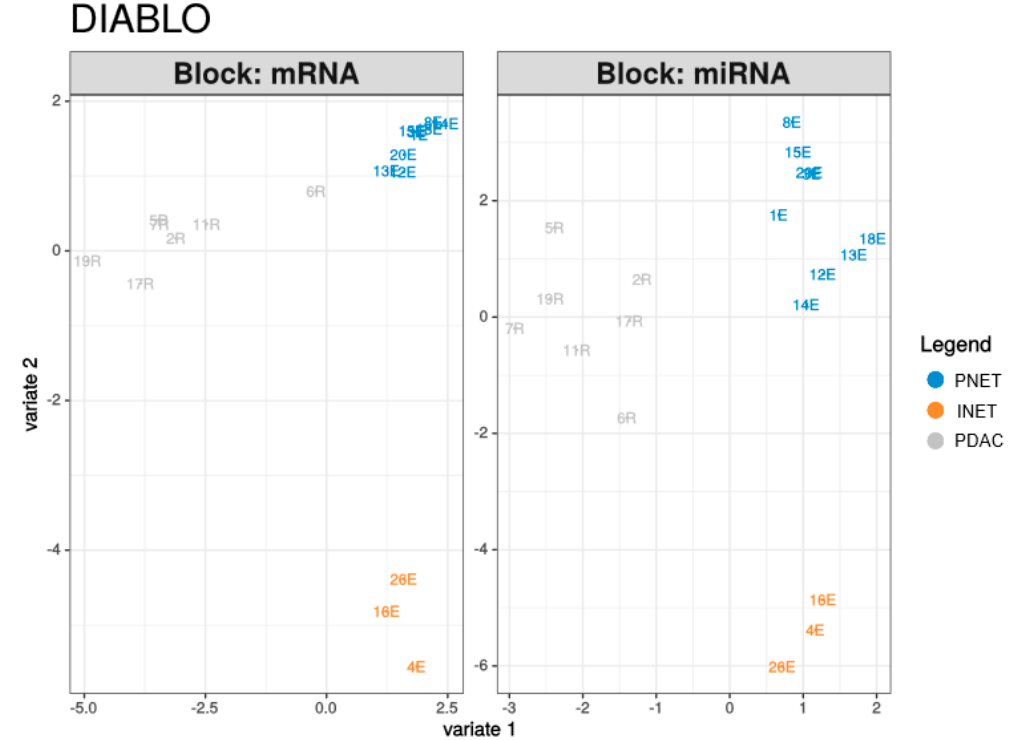
Figure 5. Scatter plot of individual samples from the DIABLO PLS-DA analysis results.